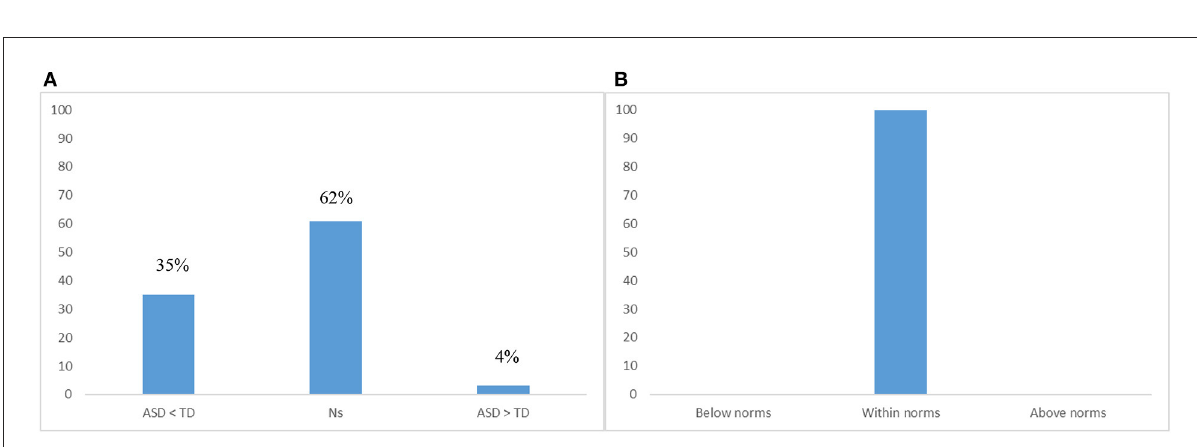
FIGURE2 (A) Percentage of tests or subtests that compared children with autism spectrum disorders (ASD) and children with typical development (TD); (B) Percentage of tests or subtests that compared children with ASD with normative scores or percentiles.